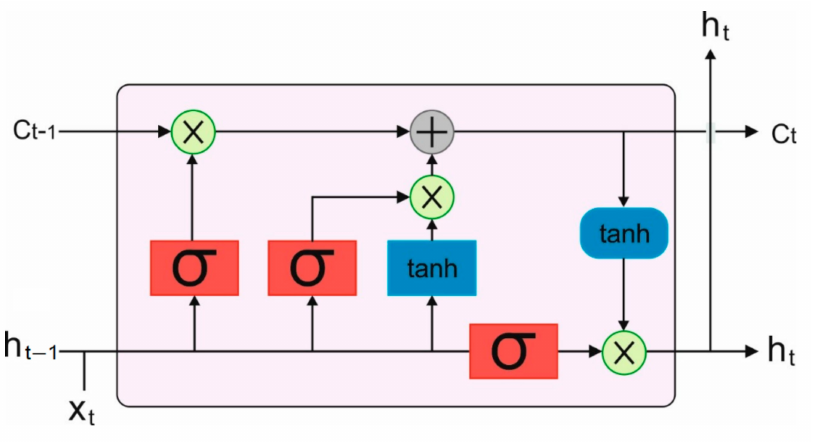
Figure 2. Infrastructure of